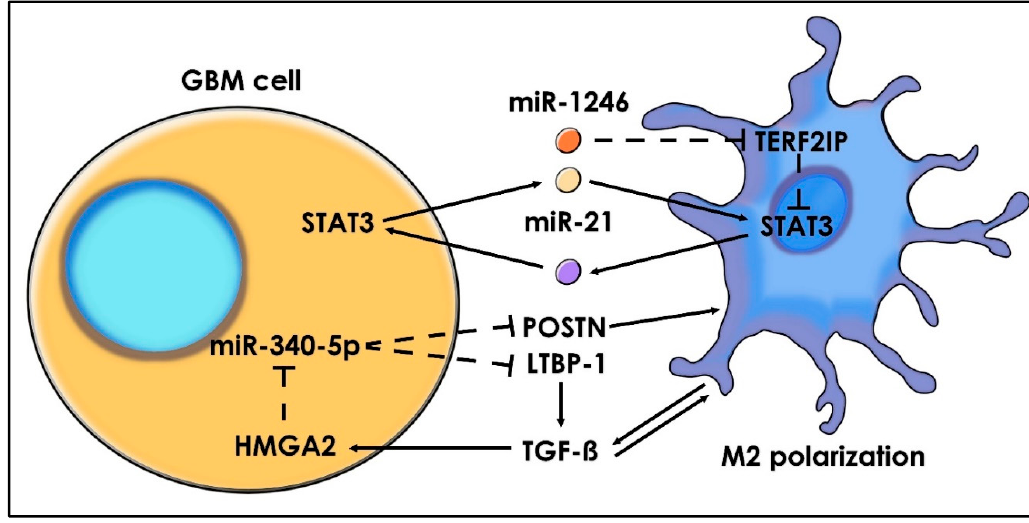
Figure 6. M2-macrophage maintenance by miRNA dysregulations in GBM.